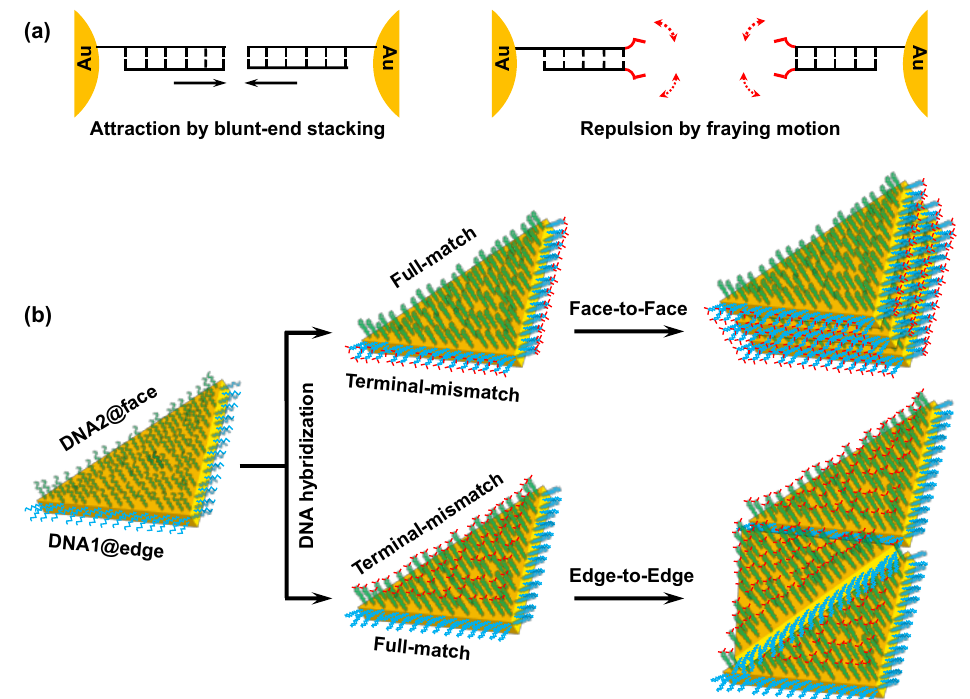
Figure 1. Directed self-assembly of gold nanotriangles (AuNTs) based on interactions between terminal single base pairs of regioselectively grafted DNAs. ( a ) Schematic illustration for attraction between fully matched dsDNAs ( left ) and repulsion between terminally mismatched dsDNAs ( right ), all of which were attached to the gold nanoparticle (AuNP) surface. ( b ) Schematic illustration of the directed self-assembly of AuNTs that were regioselectively modified with fully matched and terminally mismatched dsDNAs.